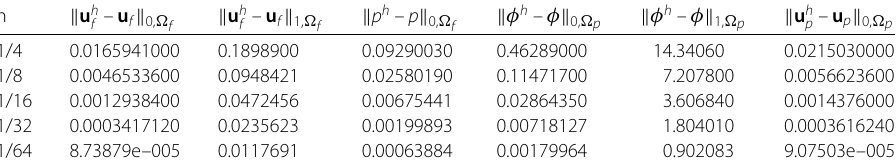
Table 3 Approximate error of the stabilized finite element scheme for test 2 with K = 0.01 I